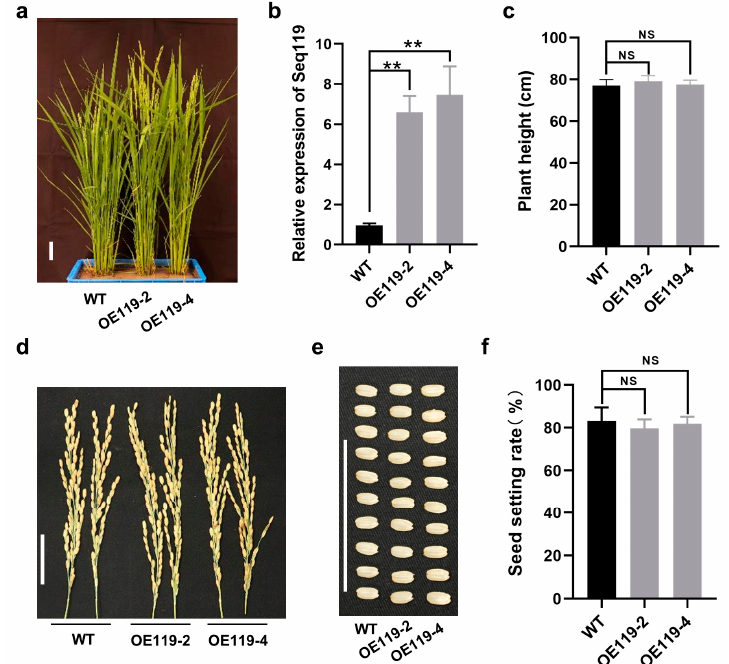
Figure 2. Overexpression of Seq119 in rice plants: ( a ) Two lines of rice plants overexpressing Seq119 (OE119-2 and OE119-4) did not show obvious changes in phenotype. ( b ) Results of qRT-PCR showing the relative expression level of Seq119 in OE119-2 and OE119-4 (**, p < 0.01). ( c ) Heights of OE119-2 and OE119-4 plants. ( d , e ) Panicles ( d ) and seeds ( e ) of WT plants and OE119-2 and OE119-4 plants. ( f ) Seed setting rate of WT plants and OE119-2 and OE119-4 plants. Bars, 4 cm. NS, no significance.